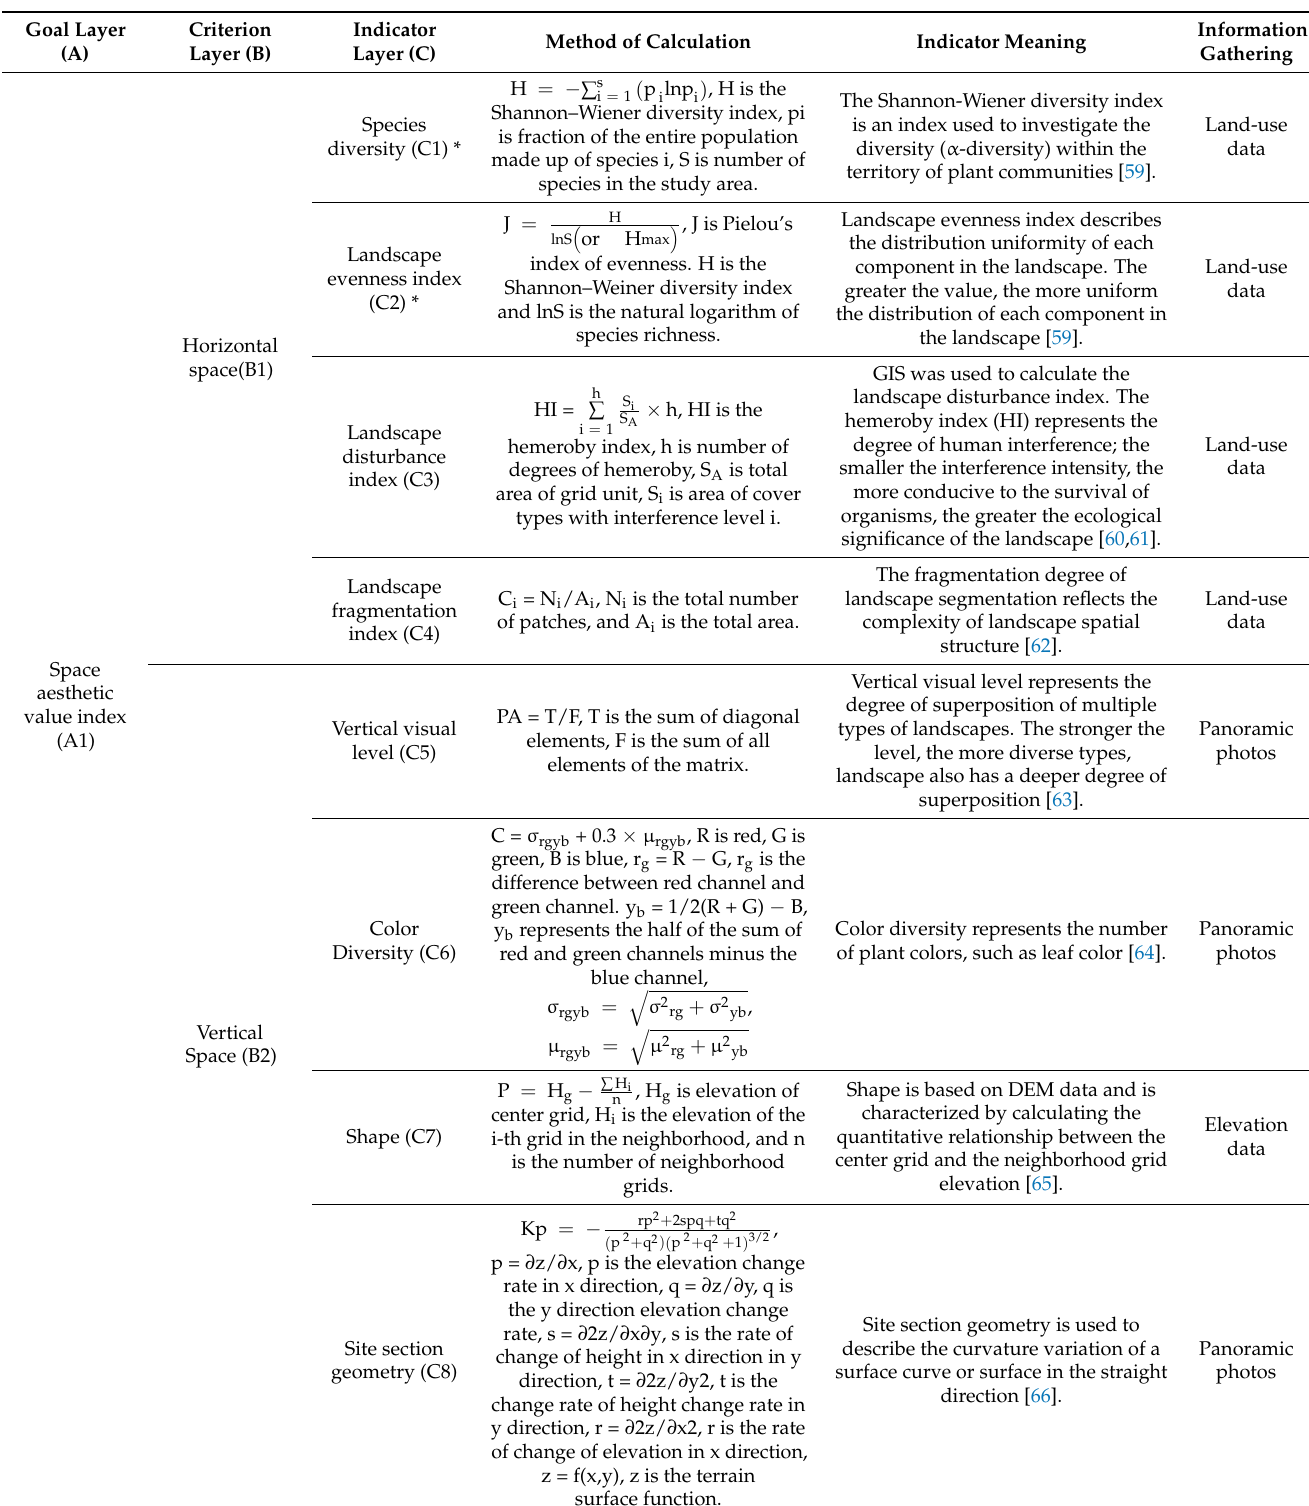
Table 2. Waterfront landscape space aesthetic value evaluation